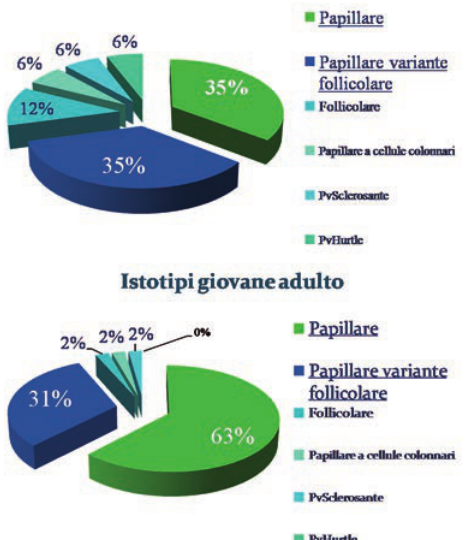
Figura 1. Istotipi pazienti pediatrici.